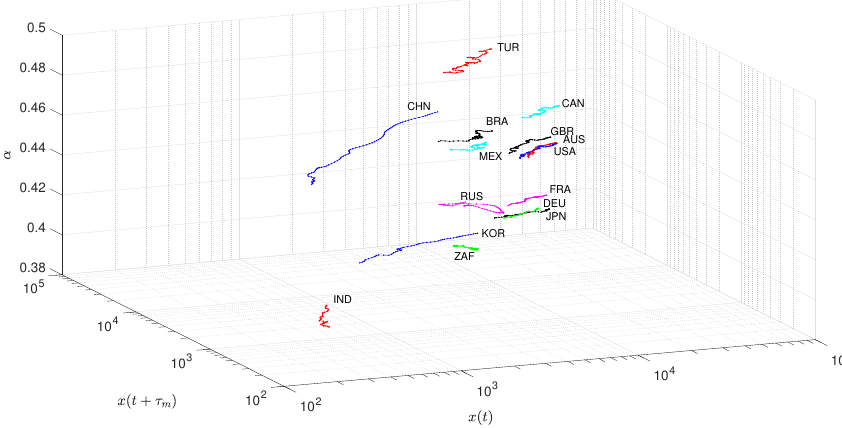
Figure 6. The locus [ x ( t ) x ( t + τ m ) α ] of GDP per capita for the set of 15 countries during